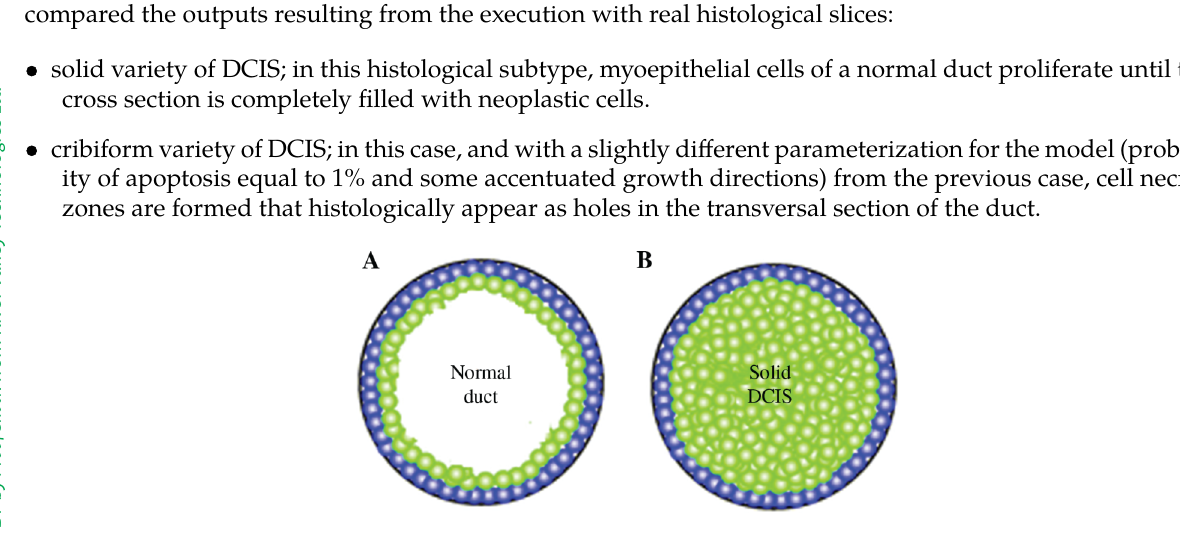
Figure 6: Simulation of the DCIS solid variety with the proposed parallel